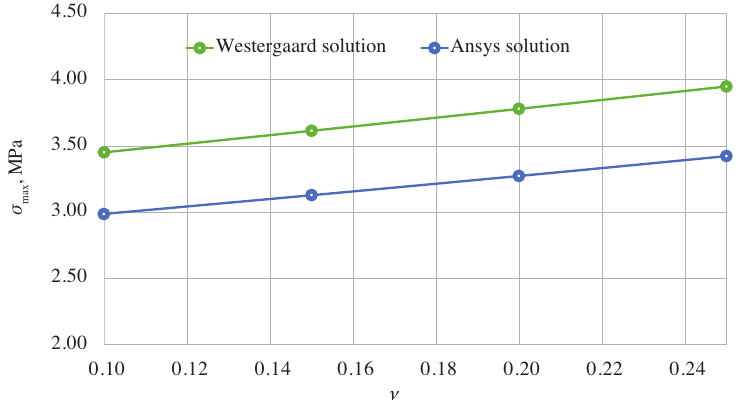
Figure 5. Variation of concrete Poisson’s ratio